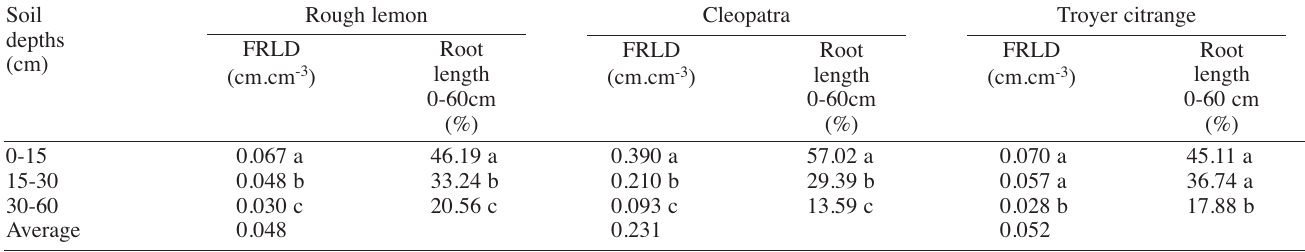
Table 1 - Pineapple orange tree mean fibrous root length density (FRLD) and percentage of root length in the radial distance up to 300 cm of the soil for rootstock and soil depth Soil depths